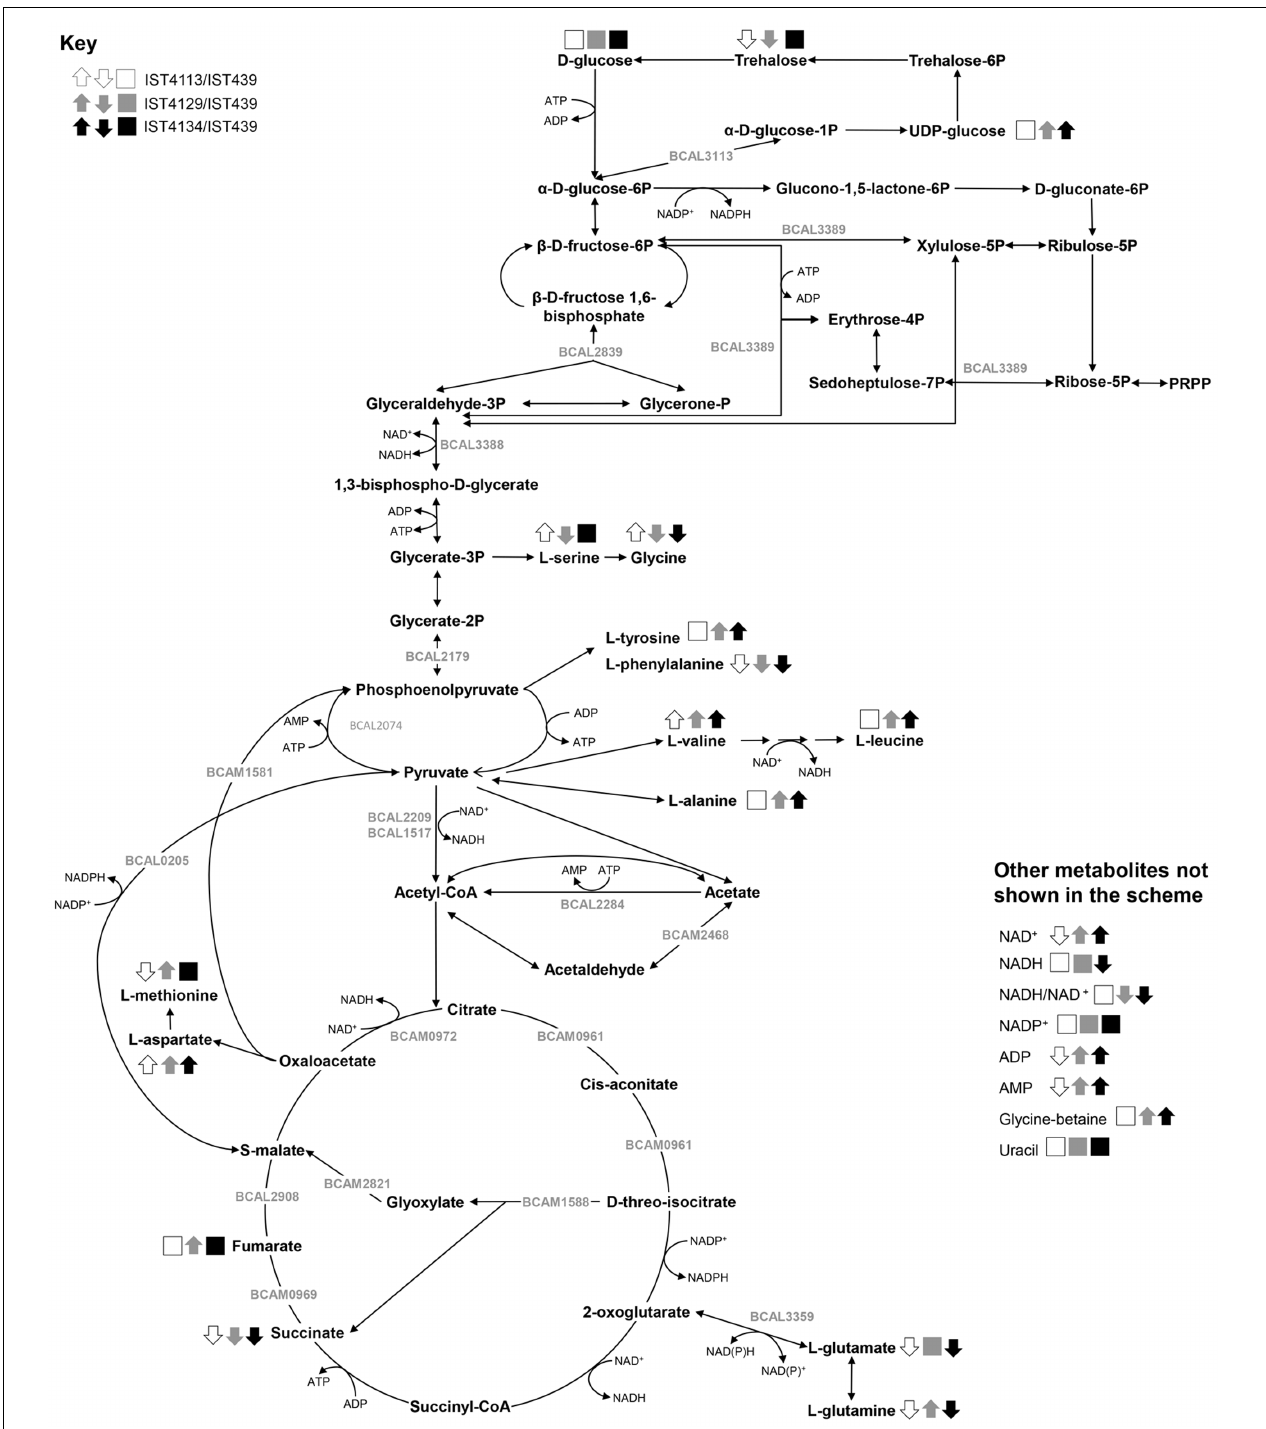
FIGURE 6 | Integrative and schematic overview of the metabolite changes detected in B. cenocepacia clonal isolates retrieved from the same CF patient. Statistically significant changes in the identified metabolites that were observed (white, gray, and black arrows) or not (white, gray, and black boxes) between the first isolate retrieved from the patient, IST439, and the late isolates IST4113 (white symbols), IST4129 (gray symbols) and IST4134 (black symbols) are shown (see key at the top left of the figure). The locus name of some of the genes and proteins with altered content in at least one of the late isolates compared with IST439 are also shown. This metabolic scheme was based on information gathered from KEGG PATHWAY Database (http://www.genome.jp/kegg/pathway.html), in BioCyc Database Collection (http://biocyc.org/) and in the metabolic reconstruction of B. cenocepacia J2315 (Bartell et al., 2014).